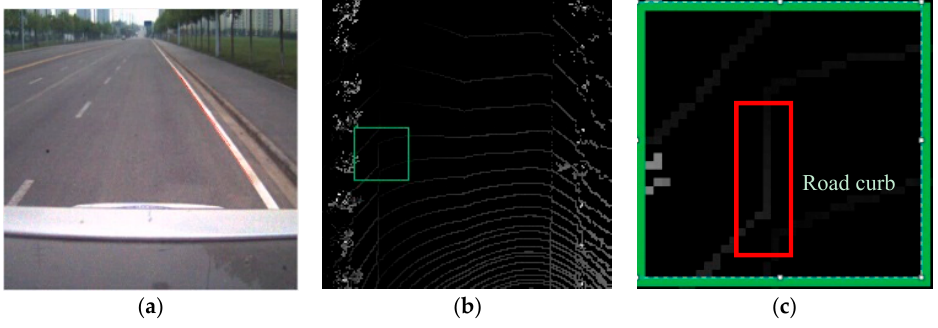
Figure 4. Result of projecting a typical driving scene onto the horizontal plane. ( a ) Real scene picture; ( b ) Grid map of yaw point cloud; ( c ) Partially enlarged detail map.